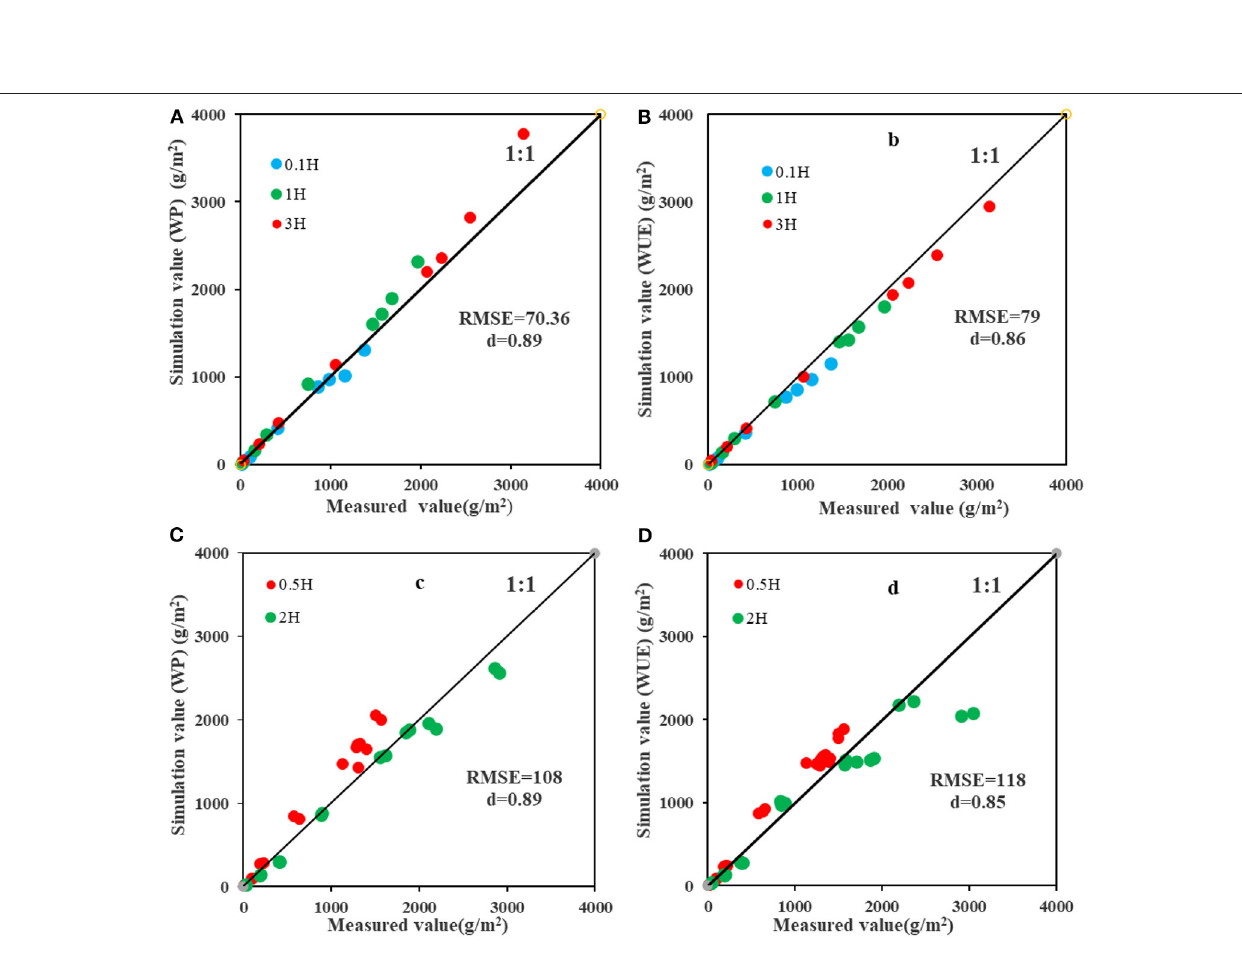
Frontiers in Plant Science |